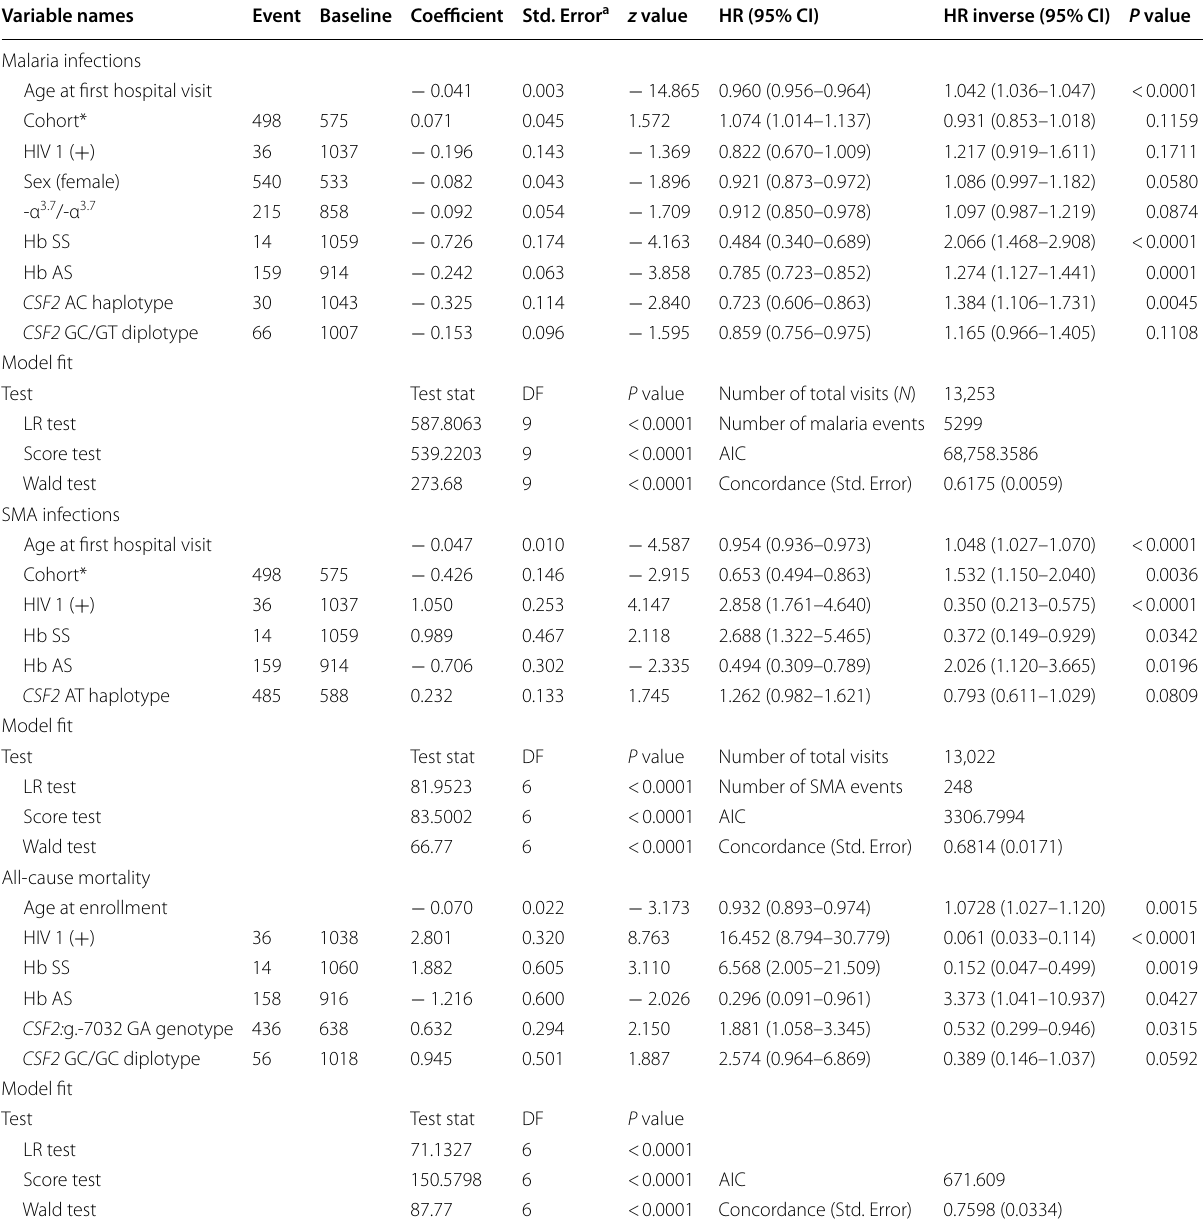
Table 4 Longitudinal risk of malaria and SMA infections and all-cause